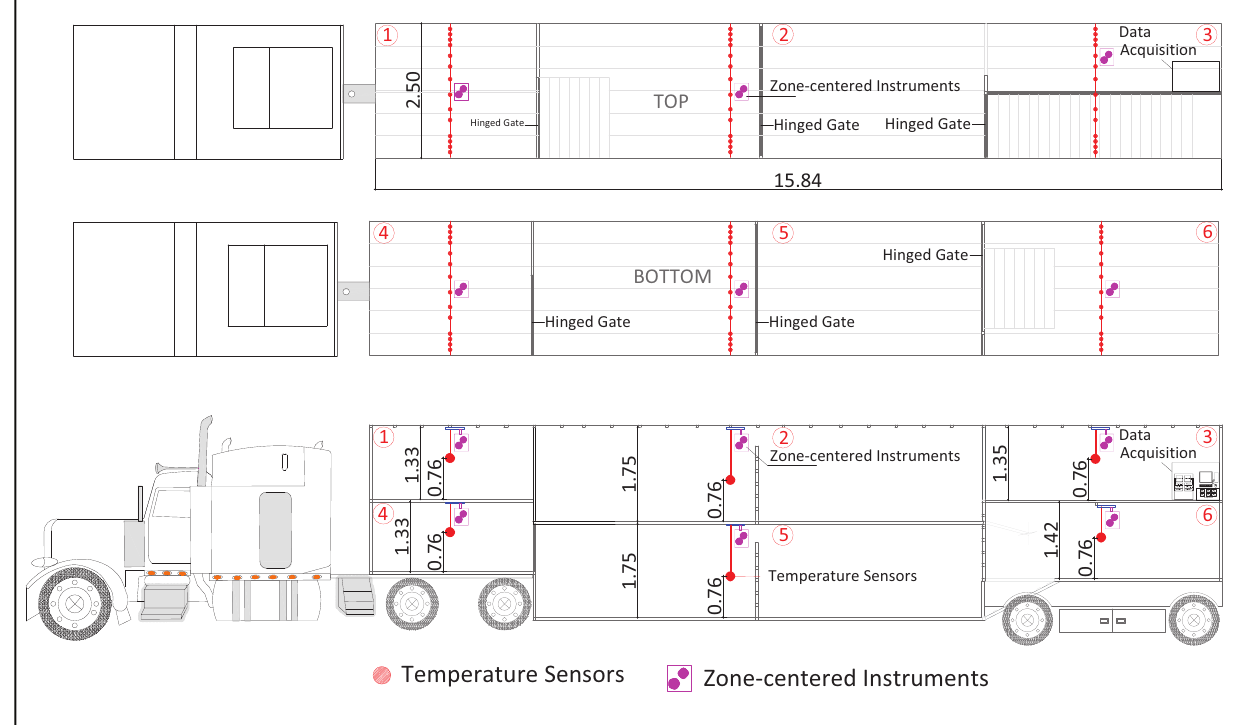
Figure 1. Trailer schematic. The top and bottom plan view of the trailer illustrates the horizontal distribution of sensors within each zone, and the left-side elevation view of the six zones illustrates the vertical distribution of sensors used for pig-level air temperature, surface temperature and zone-centered temperature/relative